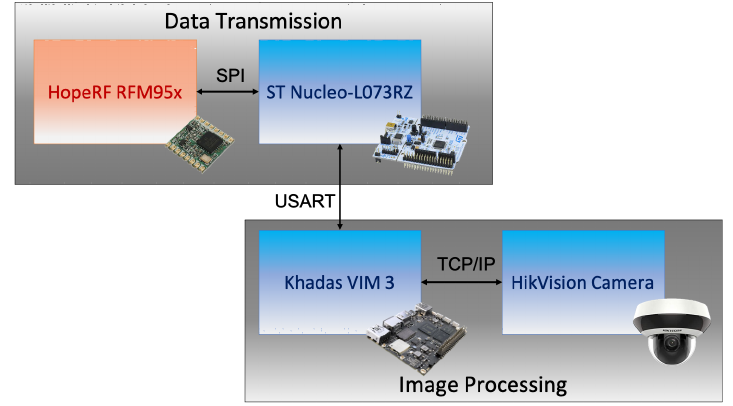
Figure 4. Video Surveillance Unit (VSU) block